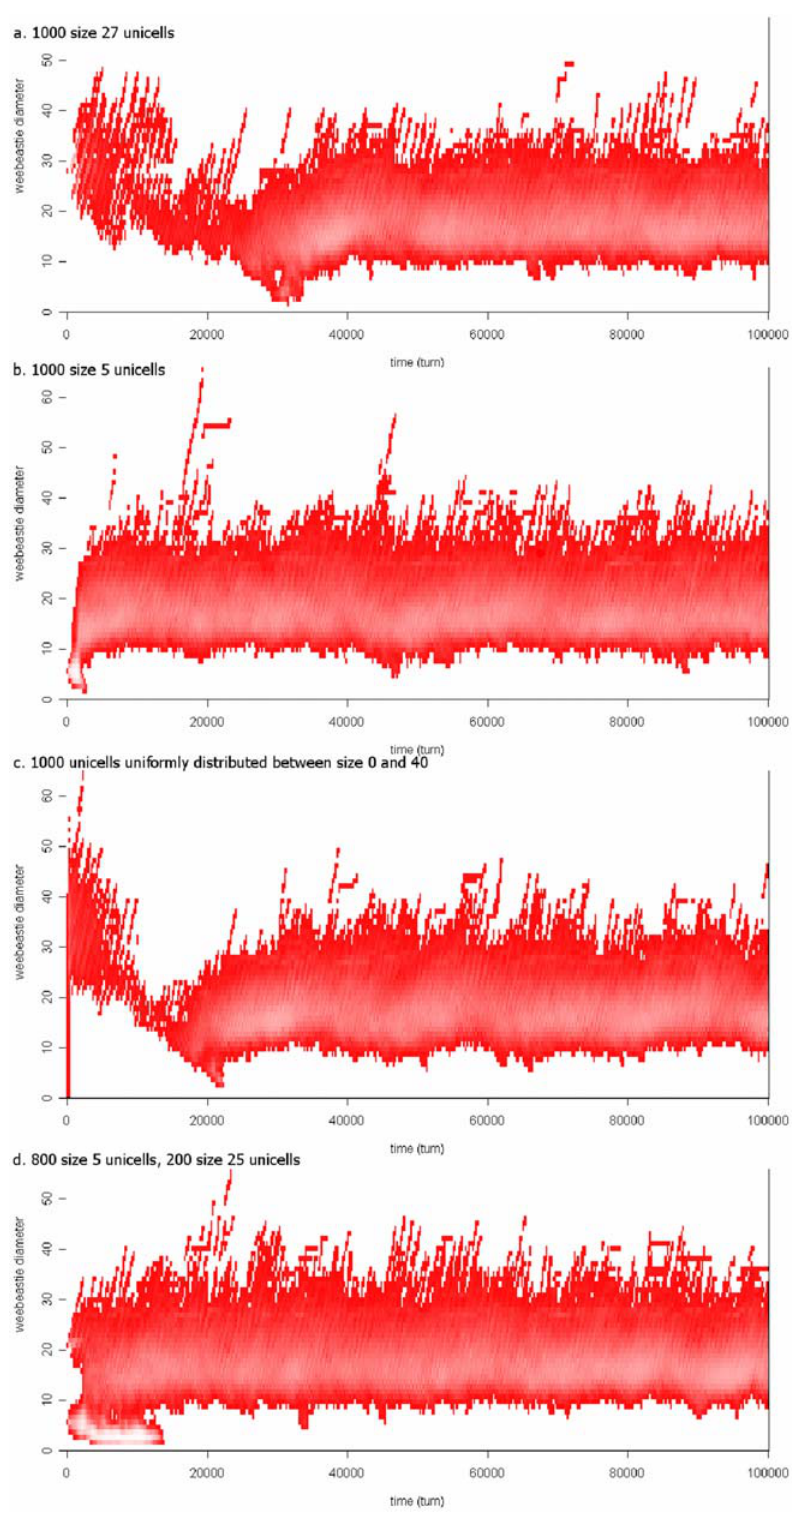
Figure 1. A stable size distribution is reached from different starting points. The vertical-axis shows unicell diameter, the x-axis is time expressed in simulation turns. The intensity of the color, ranging from dark to light red on a logarithmic scale, shows the frequencies of unicells in each size class. Although the beginning situations (1a–1d) are very different, all 4 simulations converge to similar population dynamics. In 1a and 1b all cells start at the same size but are larger (1a) or smaller (1b) than the final average size. In 1c and 1d the sizes of the initial unicells are selected from either a uniform (1c) or bimodal (1d) distribution. Additional information on conditions and parameter values are described in Supplementary Information.